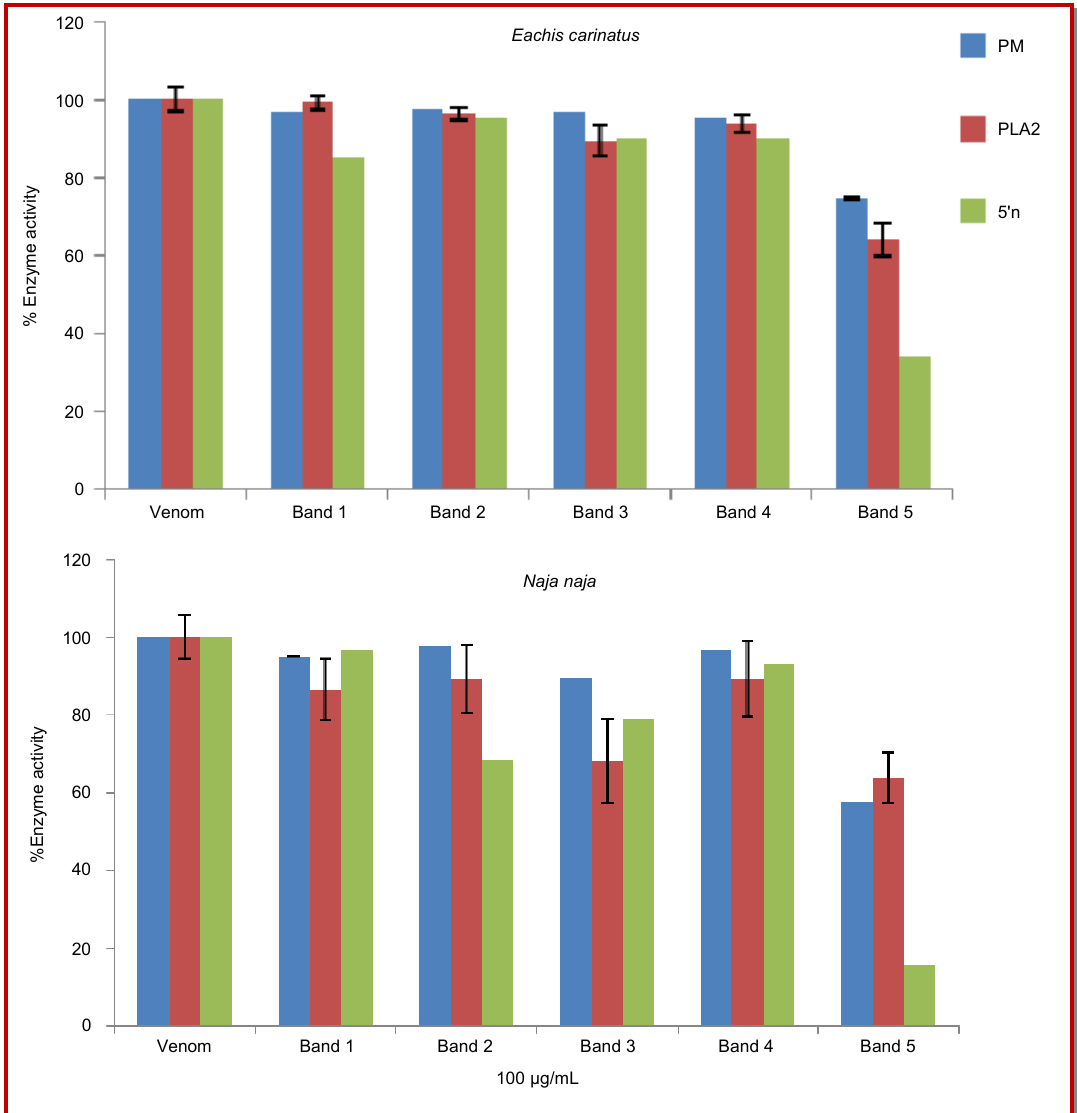
Figure 3: Neutralization of Protease (P), Phospholipase A 2 (PLA2), 5’ nucleotidase (5’n) activities of E. carinatus or Naja naja venom by TLC separated methanol extracts. Results were expressed mean ±